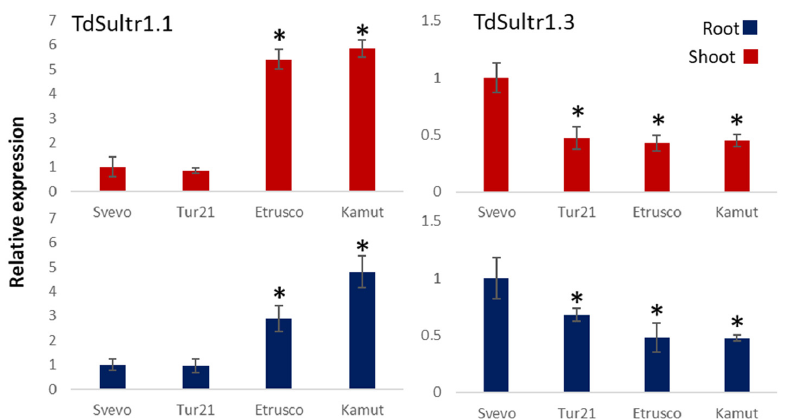
Figure 3. Expression of genes coding for high-affinity sulfate transporters. Expression of genes coding for two high-affinity sulfate transporters (TdST1.1 and TdST1.3) in root and shoot tissues of four wheat genotypes (Svevo, Tur-21, Kamut, and Etrusco) by qRT-PCR. Plants were grown being exposed to low sulfate level (L, 0.06 mM sulfate) and 50 mM Se, provided as selenate. Data are shown as fold differences in transcript abundance between the control (cv. Svevo) and three tetraploid genotypes belonging to ssp. turanicum (Tur21, Etrusco, and Kamut). Standard error bars are indicated. Genes significantly ( p < 0.05) up- or downregulated are marked by an asterisk (*). The root sulfate transport system is not only responsible for sulfate uptake but also for selenate uptake, because of their chemical similarity [4,10]. For this reason, the role of S nutrition on Se accumulation in the root and shoot tissues of wheat plants was determined, and the results obtained are reported in Tables 1 and 2.